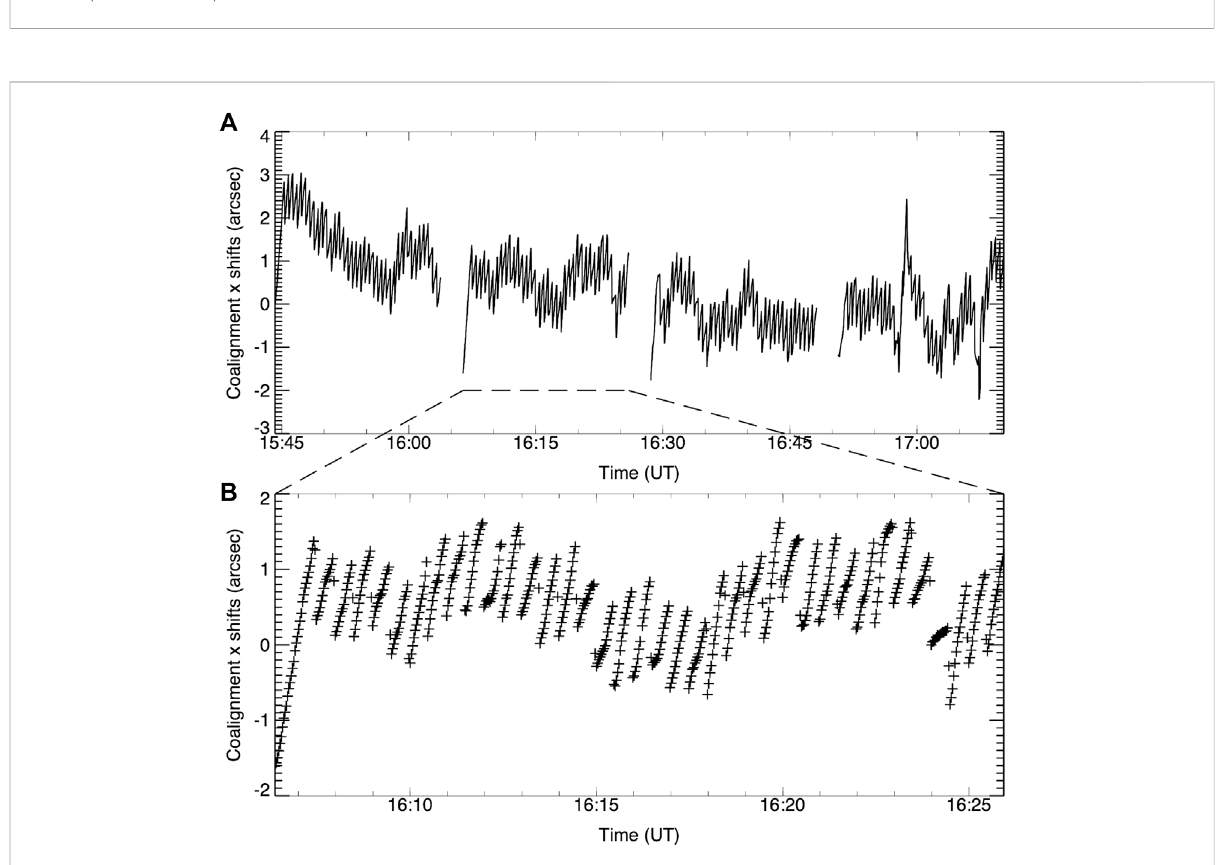
Frontiers in Astronomy and Space